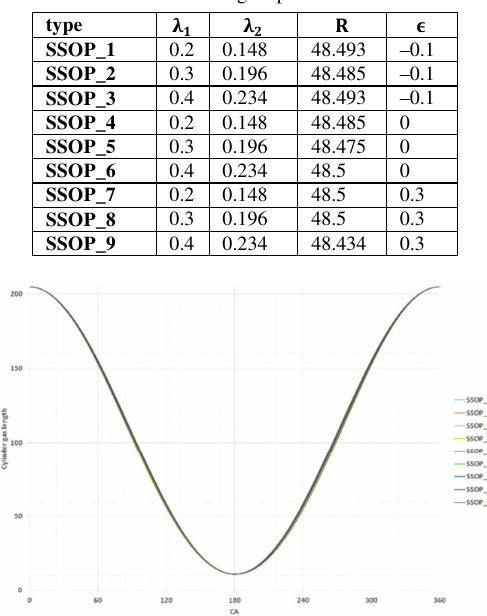
Fig. 9. EE piston motion curves Table 4. Geometrical engine parameters for SSOP